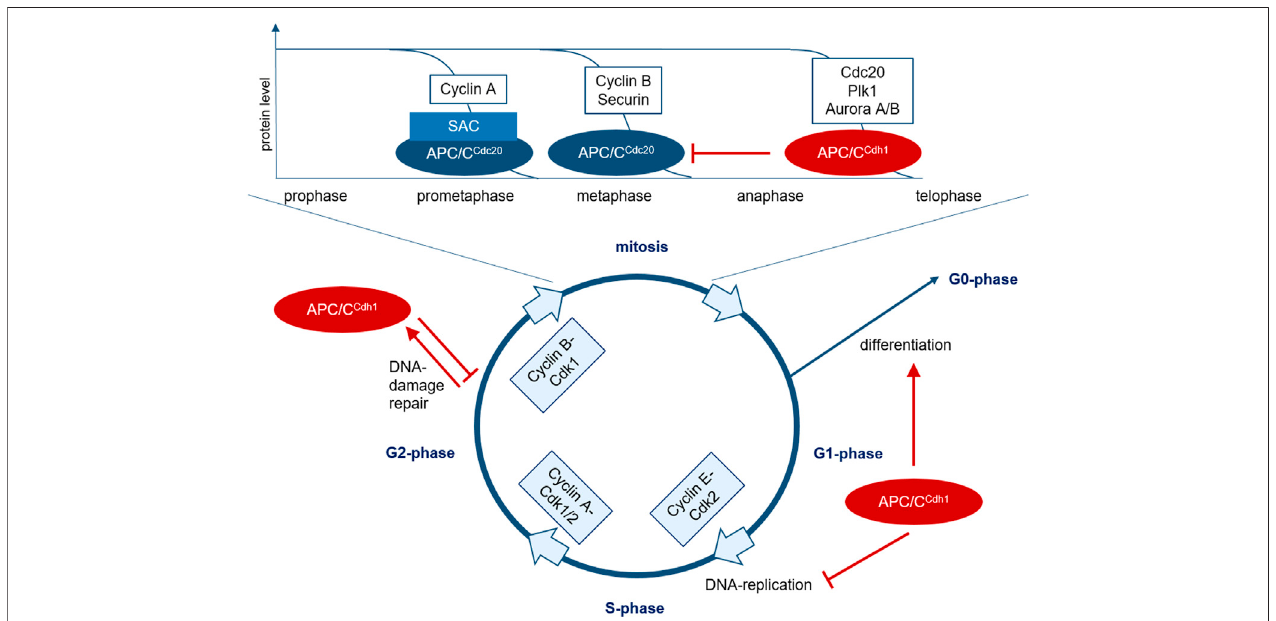
FIGURE 1 | The role of APC/C in cell cycle regulation. The transition between the cell cycle phases is regulated by the cyclic activity of cyclin-Cdk complexes. In mitotic entry, cyclin B-Cdk1 plays a crucial role. In early prometaphase, chromosomes bind to the mitotic spindle and improperly connected kinetochores lead to SAC- activation.At fi rst,thispartiallyinhibitssubstraterecruitmentofAPC/Cactivated via Cdc20,butvariousprometaphaseproteinssuchascyclinAcanbefurthermarkedfor degradation by SAC-APC/C Cdc20 . After correct attachment of all chromosomes to the mitotic spindle, the SAC is inactivated, leading to degradation of additional proteins such as cyclin B and securin via APC/C Cdc20 in metaphase, mediating chromosome segregation and initiating mitotic exit. Cyclin B-degradation leads to Cdk1 inhibition,resultingindephosphorylationandactivationofCdh1.APC/C Cdh1 theninitiatesthedegradationofvariousproteinsduringana-andtelophasesuchasCdc20, Plk1, and Aurora A/B.Attheend ofmitosis, APC/C Cdh1 inactivates APC/C Cdc20 and regulates anaphasespindledynamics and cytokinesis. APC/C Cdh1 isthus activated fromlatemitosisandcontrolsthedecisionbetweenproliferationanddifferentiation inG1-phase.InG2-phase,APC/C Cdh1 canbeactivatedinresponsetoDNA-damage to prevent mitotic entry and allow DNA-repair.SAC, spindle assembly checkpoint; APC/C, anaphase promoting complex; Plk, Polo-like Kinase; Cdk, cyclin-dependent